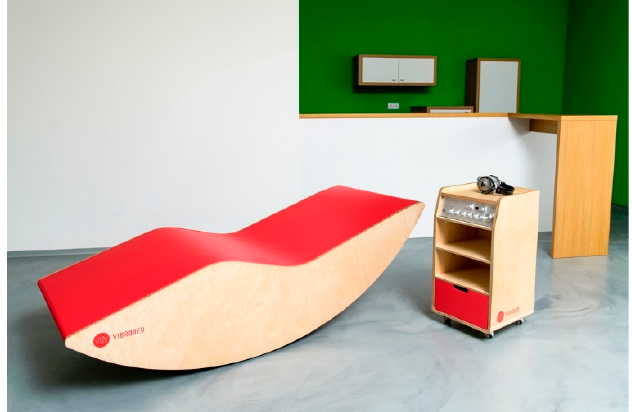
Figure 1. Rehabilitation vibration bed VIBROBED ® (from the authors’ archive).